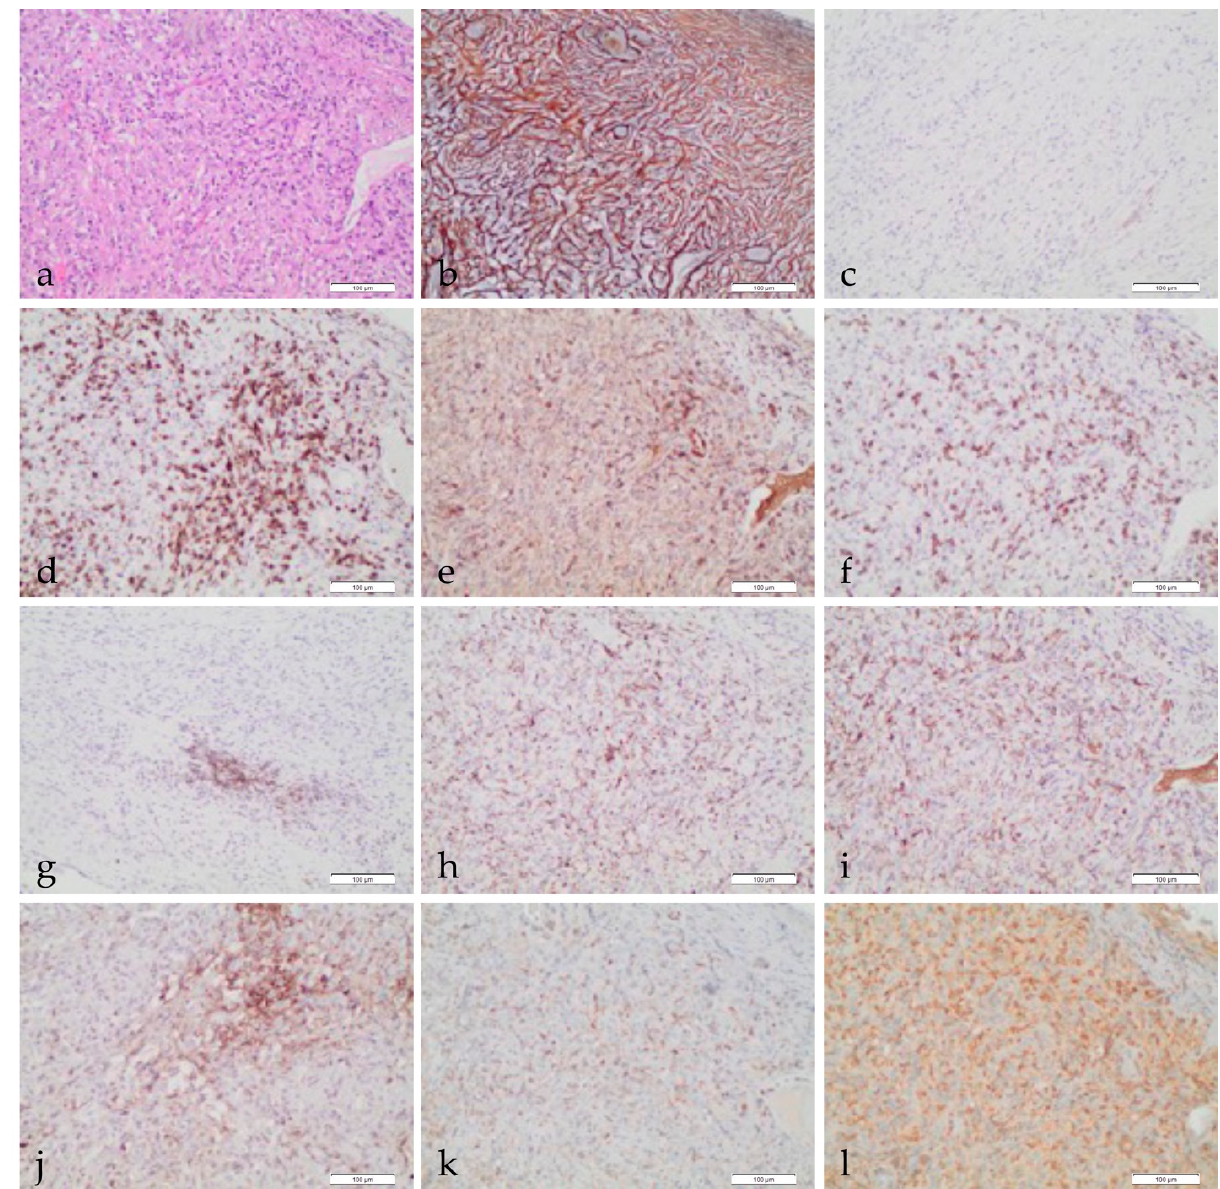
Figure 1. Pathological characterization of TIME in MPM. Histological appearance of MPM, epithelioid type ( a ), Ematoxilin & eosin (100 × ); reticulin stain showing connective tissue around neoplastic cells ( b ), (100 × ); SMA IHC stain showing scattered fibrocytes ( c ), (100 × ); CD3 IHC stain highlighting T lymphocytes ( d ), (100 × ); CD4 IHC stain showing scattered T cells ( e ), (100 × ); CD8 IHC stain showing moderate T lymphocyte infiltrate ( f ), (100 × ); CD20 IHC stain showing a small aggregate of B lymphocytes ( g ), (100 × ); CD68 IHC stain showing diffuse macrophage infiltration ( h ), (100 × ); CD163 IHC stain showing activated TAMs ( i ), (100 × ); PD-L1 IHC stain showing small aggregates of positive tumor cells ( j ), (100 × ); VISTA IHC stain showing moderate expression in immune cells ( k ), (100 × ); STING IHC stain showing diffuse immune cell positivity ( l ), (100 × ). Notes: TIME: tumor immune microenvironment; MPM: malignant pleural mesothelioma; SMA: smooth muscle actin; IHC: immunohistochemistry; PD-L1: programmed death ligand 1; VISTA: V-domain Ig-containing suppressor of T-cell activation; STING: STimulator of Interferon